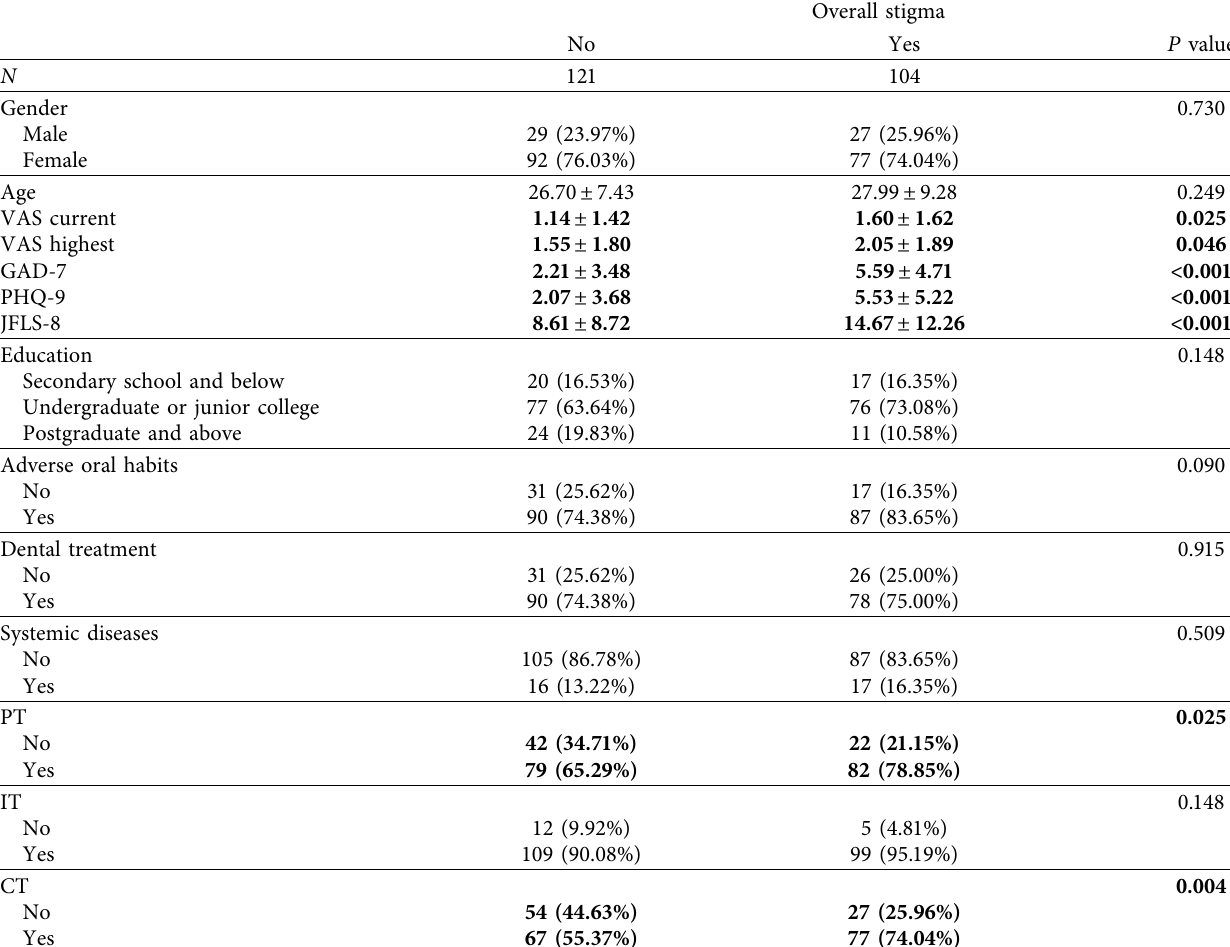
Table 2: Effects of clinical characteristics and quantitative variables on overall